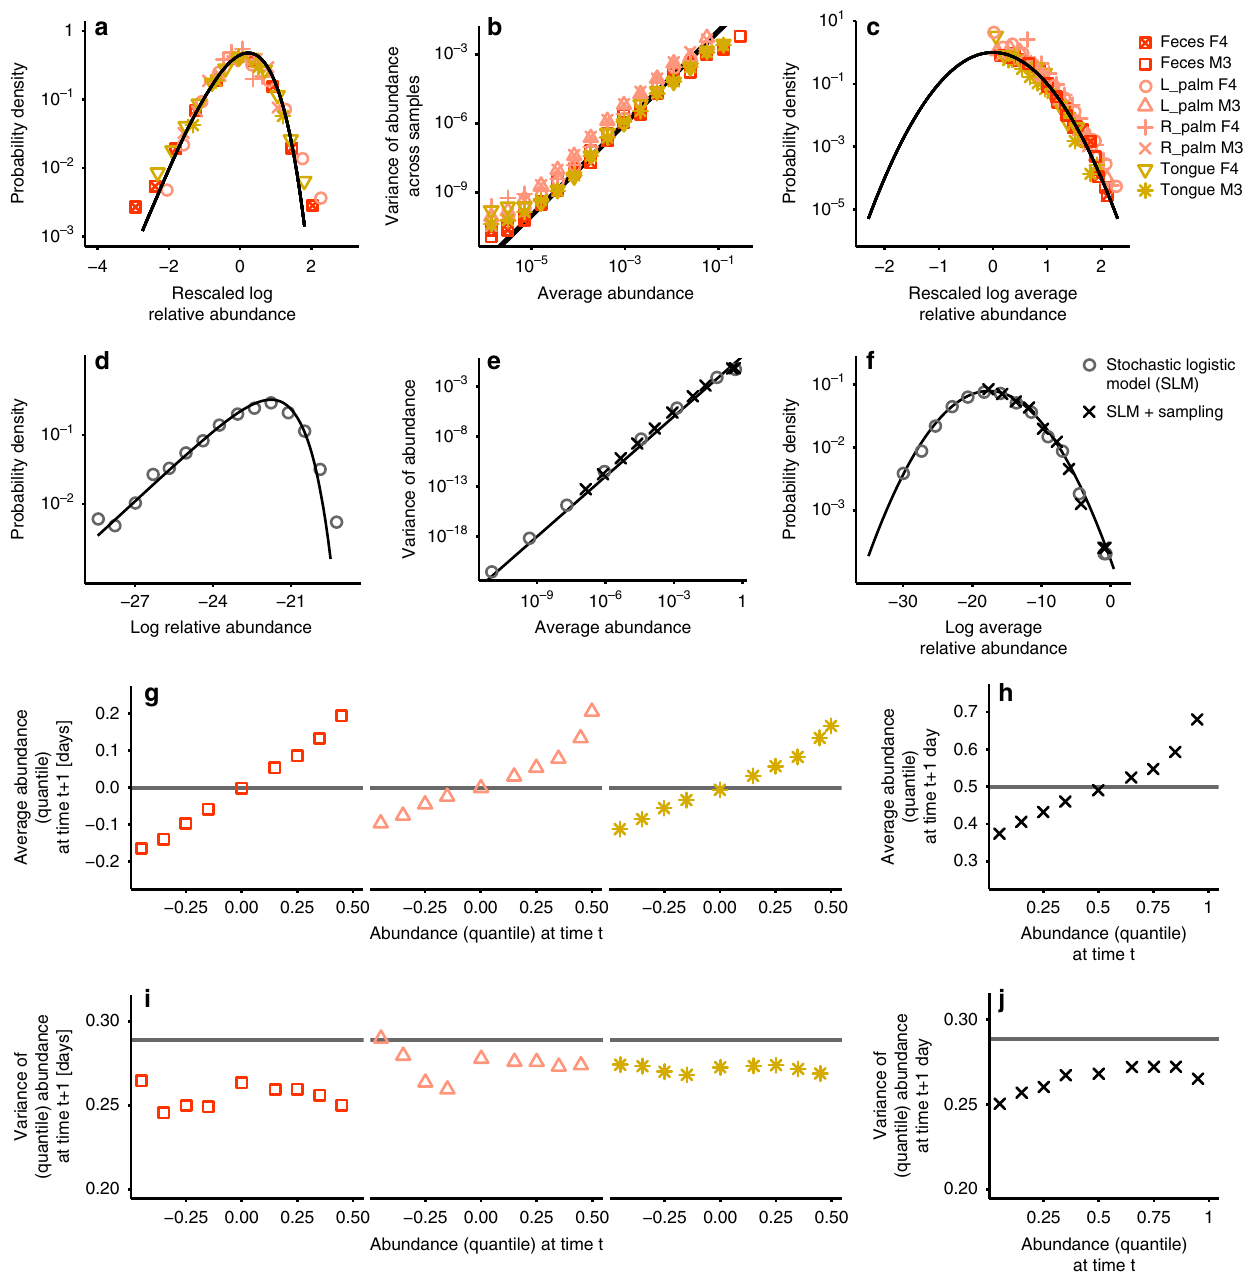
Fig. 4 Macroecological laws hold for temporal data. a – c The same laws that describe presence and abundance variation across the community (black lines) also hold for time data (colored points, see Methods and Supplementary Note 9). d – f The stochastic logistic model (SLM) reproduces the empirically observed AFD, Taylor's law and MAD, respectively. Gray circles are the results obtained with the SLM, and the black crosses the ones obtained using SLM together with sampling. g The average quantile abundance given an average quantile abundance in the previous day (averaged over species, see Methods). The gray solid line shows the expected relation in the absence of time dependence. i Similar to ( g ), the variance of the quantile abundance given an average quantile abundance in the previous day (averaged over species). h , j The SLM correctly predicts the non-stationary properties shown in ( g ) and ( i ) (see